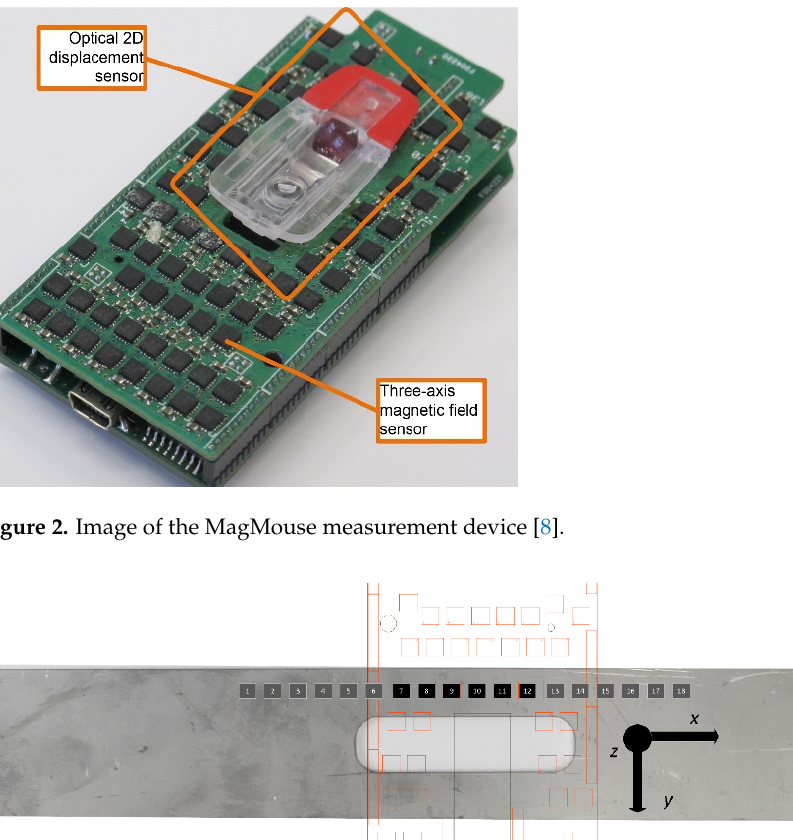
Figure 3. Arrangement of the magnetic field sensors (measurement points) relative to the tested sample.